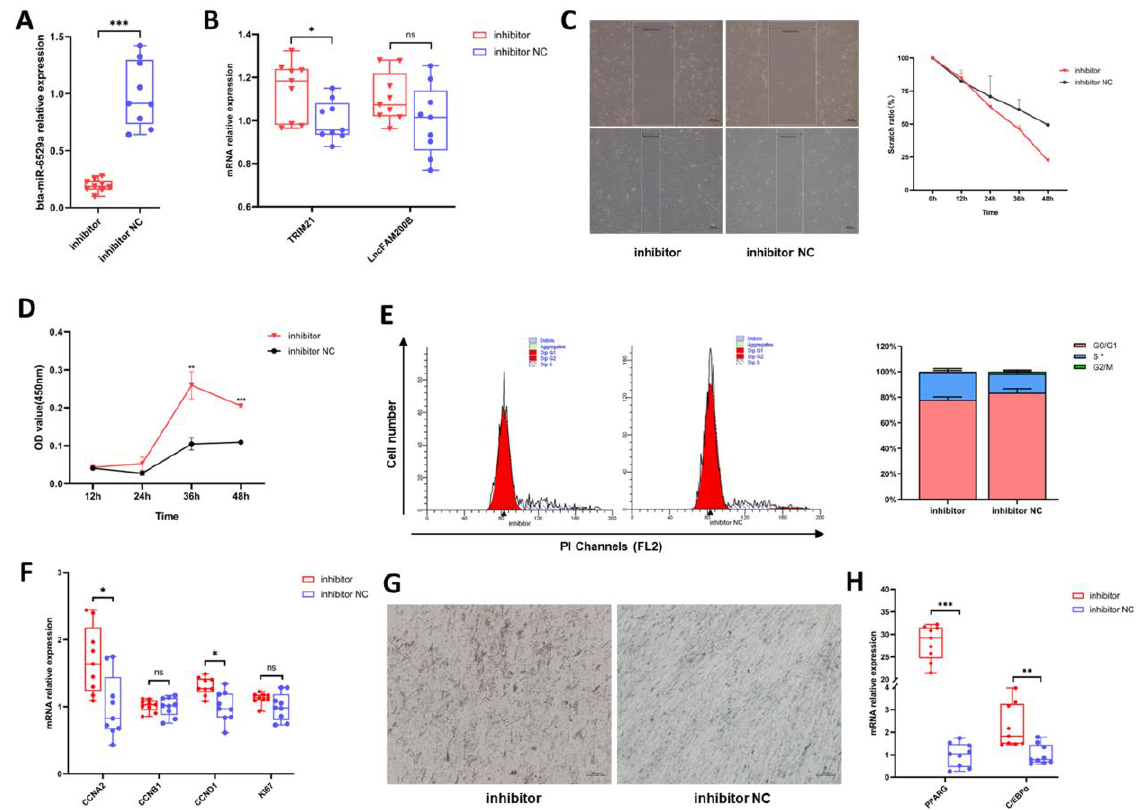
Figure 8. Effects of suppression of miR-6529a expression on the proliferation and differentiation of preadipocytes. ( A ) Inhibition of miR-6529a. ( B ) The mRNA expression levels of TRIM21 and lncFAM200B after miR-6529a inhibition. ( C ) Scratch test. The top figures are results at 0h and the bottom figures are results at 36h. ( D ) CCK-8 results. ( E ) Flow cytometry after miR-6529a inhibition. ( F , H ) are the expression of proliferation marker and differentiation marker after inhibition of miR-6529a, respectively. ( G ) Oil red O staining results. Results are presented as mean ± SD, * p < 0.05. ** p < 0.01. *** p < 0.001.